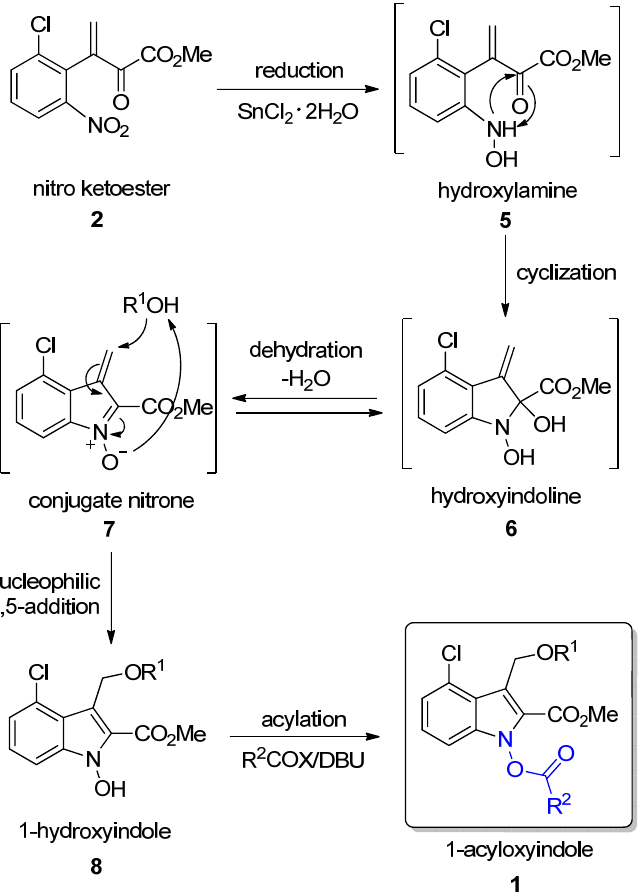
Scheme 2. Proposed scheme for synthesis of multisubstituted 1 ‐ acyloxyindoles 1